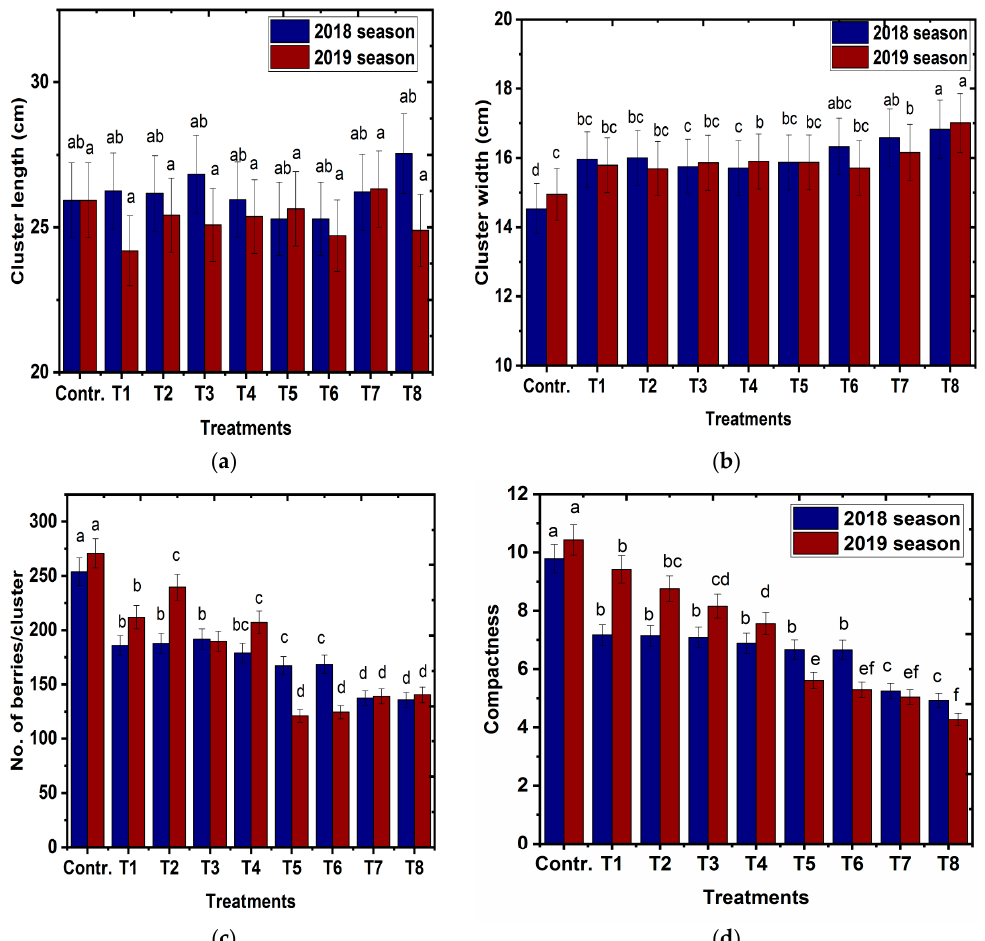
Figure 5. Effect of hand thinning and GA 3 sizing on ( a ) cluster length, ( b ) width, ( c ) No. of berries/cluster and ( d ) compactness of “Sultanina grapevines (H4 strain) in the 2018 and 2019 seasons. Contr. without removing any shoulders of the cluster, T1:25% hand thinning + 20 ppm GA 3 sizing, T2:25% hand thinning + 30 ppm GA 3 sizing, T3:25% hand thinning + 40 ppm GA 3 sizing, T4:25% hand thinning Without GA 3 sizing, T5:50% hand thinning + 20 ppm GA 3 sizing, T6:50% hand thinning + 30 ppm GA 3 sizing, T7:50% hand thinning + 40 ppm GA 3 sizing and T8:50% hand thinning Without GA 3 sizing. Means in each column followed by the same letter (s) are not significantly different at ( p ≤ 0.05), using Duncan’s Multiple Range Test.